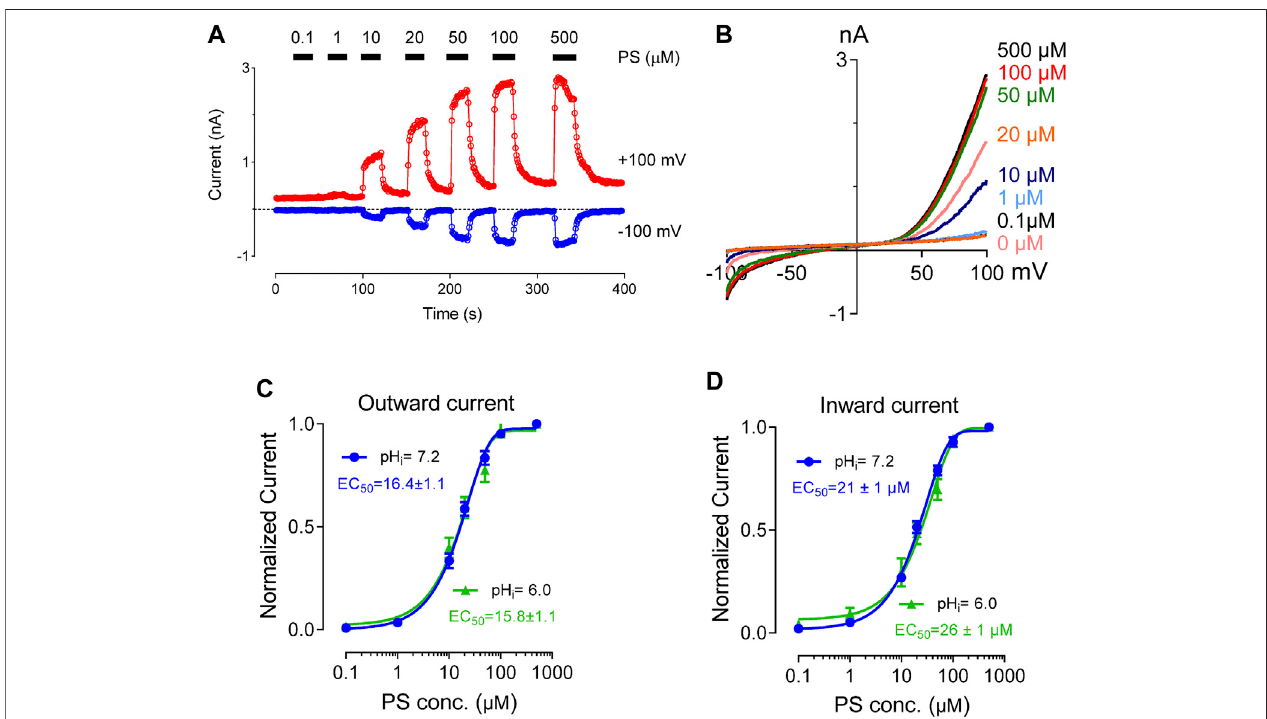
FIGURE 3 | Concentration-response curve for PS-induced currents in hTRPM3, at the indicated intracellular pH. (A) Time course of TRPM3 currents elicited by voltage ramps ranging − 100 to +100 mV. PS was applied extracellularly in increasing concentration sequence at concentrations of 0, 0.1, 1, 10, 20, 50, 100, and 500 µM, with an adequate washing period between subsequent PS applications. (B) Representative recording of TRPM3 current at the indicated PS concentration in (A) . (C) Outward current normalized tomaximum concentration-response(500 µM) of the PS, with error bars showing SEM ( n (cid:2) 7 cells). The EC 50 values of PS for theoutward currentsare16.4 ± 1.1 µMatpH7.2and15.8 ± 1.1 µMatpH6.0. (D) .Inwardcurrentnormalized tomaximumconcentration-response(500 µM)ofthePS, with error bars showing SEM ( n (cid:2) 7 cells). The EC 50 values of PS for the inward currents are 21.0 ± 1.0 µM at pH 7.2 and 26.0 ± 1.0 µM at pH